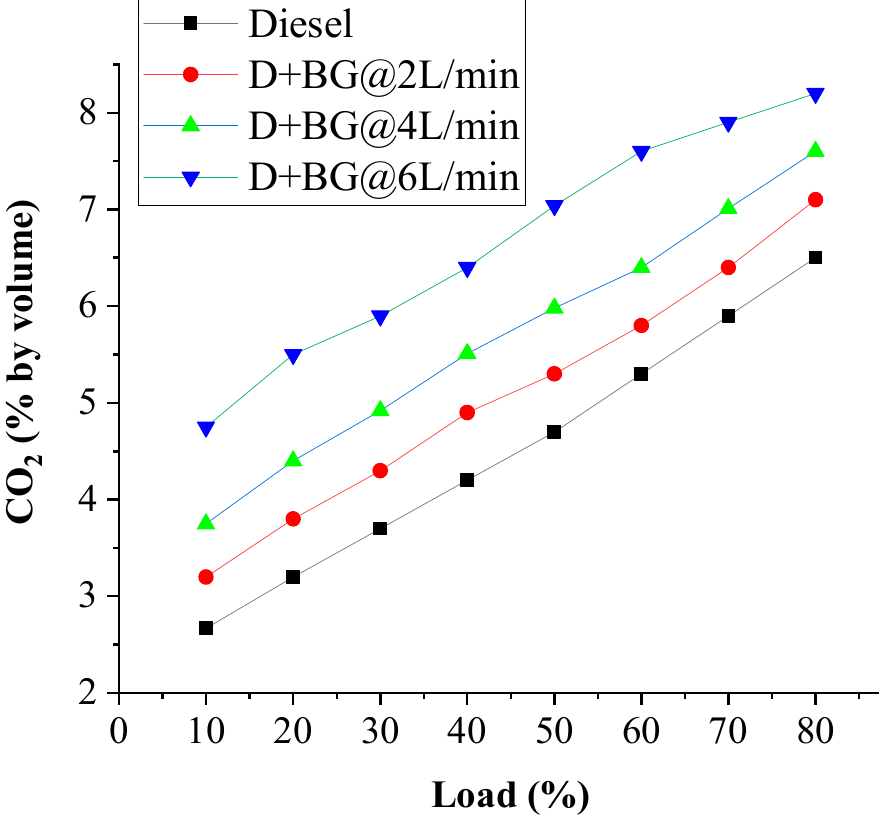
Figure 8. Variation of CO 2 with respect to